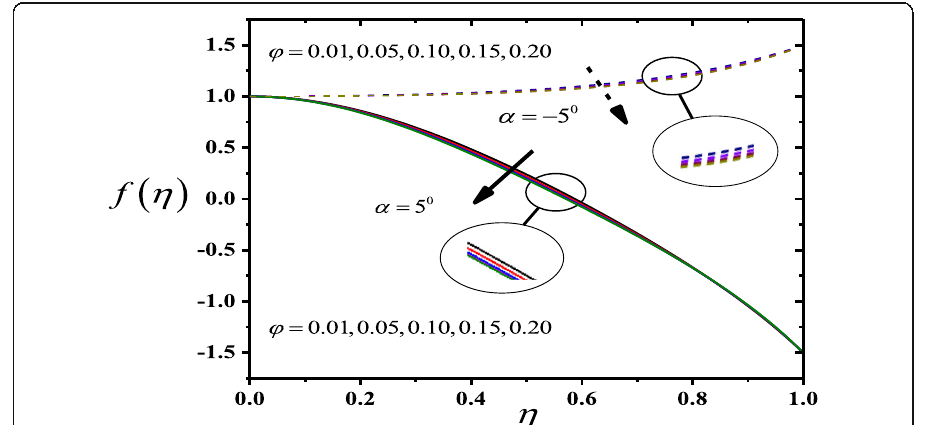
Fig. 15 Velocity vs. φ in shrinking divergent and stretching convergent